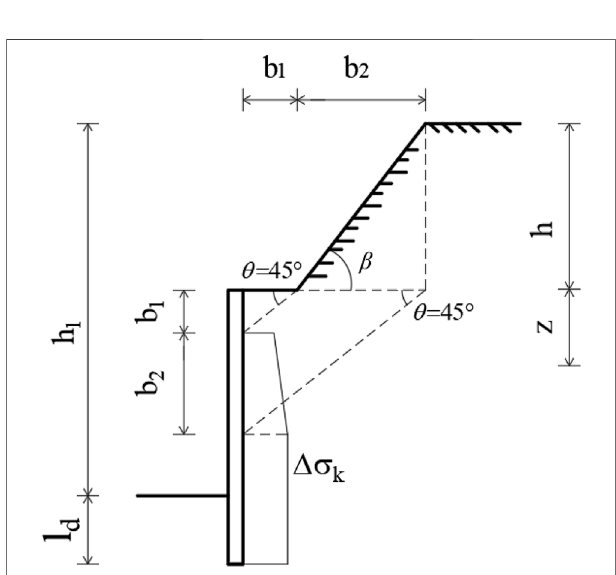
FIGURE17| Calculationofadditionalverticalstresses inslopingearthat the top of retaining walls.